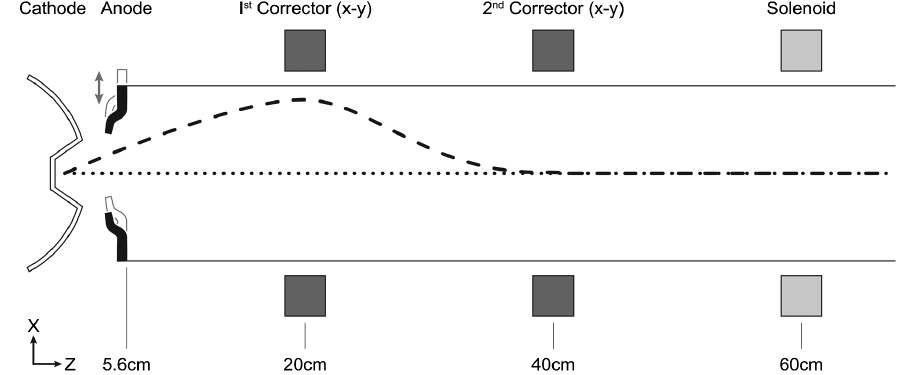
gap.FIG. 4. Schematic of the beam line components used for simulation, the Helmholtz coil in the dc gap is not shown. The dotted and dashed lines represents on axis and offset anode operation, respectively. Components and distances are not to